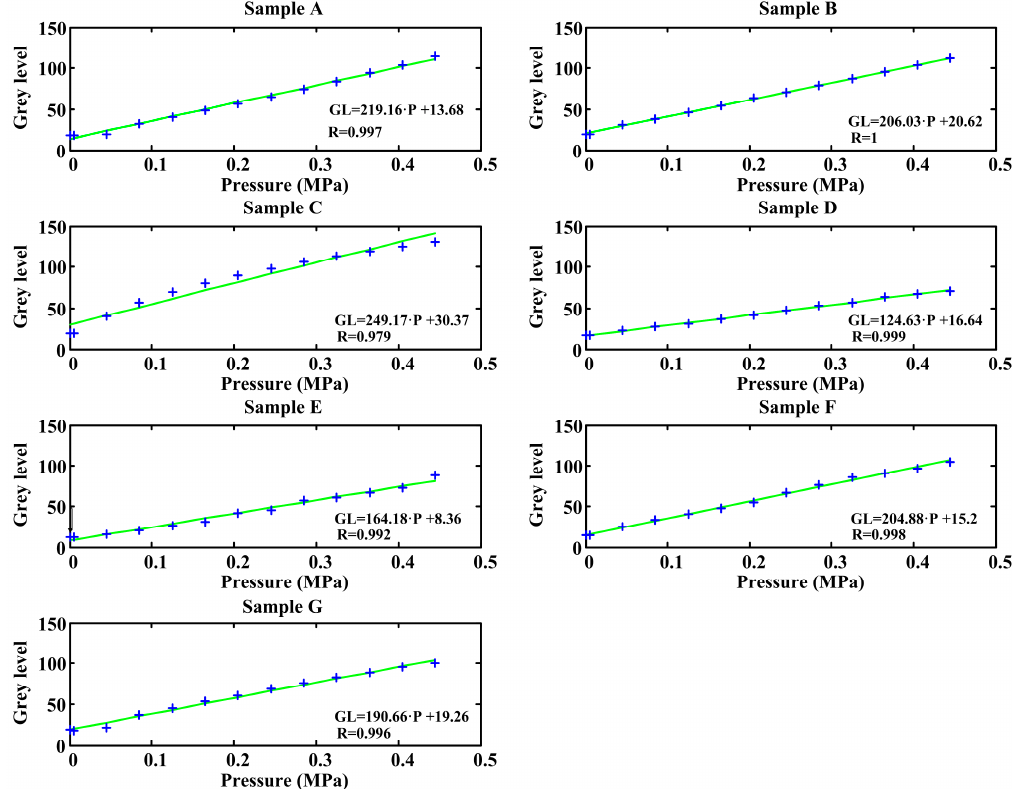
Figure 5. Samples calibration.